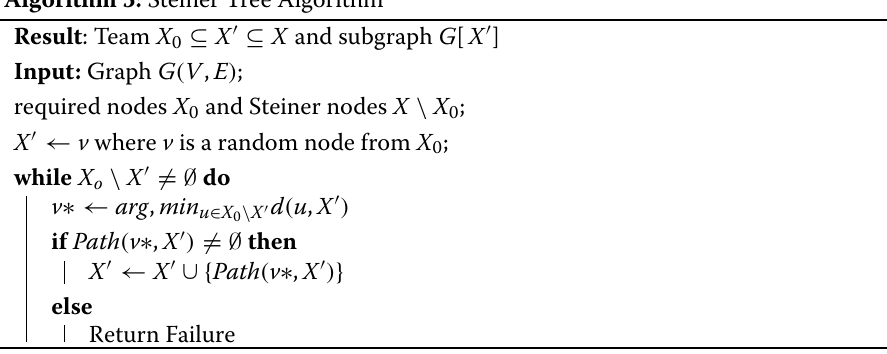
Algorithm 5: Steiner Tree Algorithm